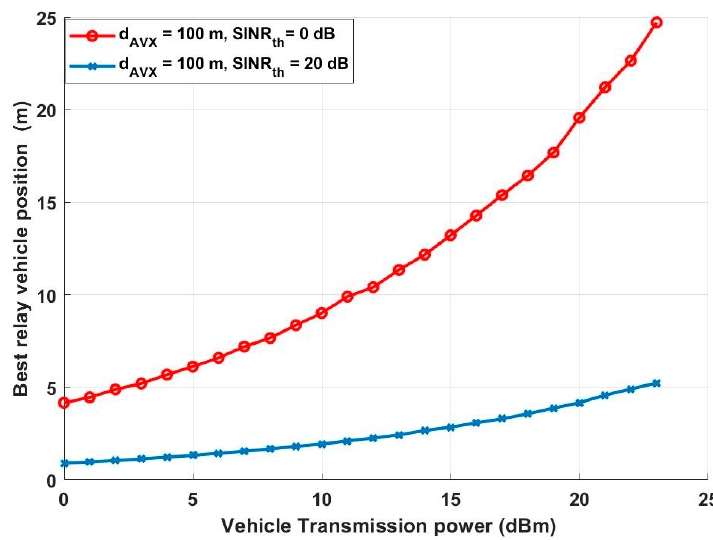
Figure 5. Vehicle transmission power vs. best relay-vehicle position.